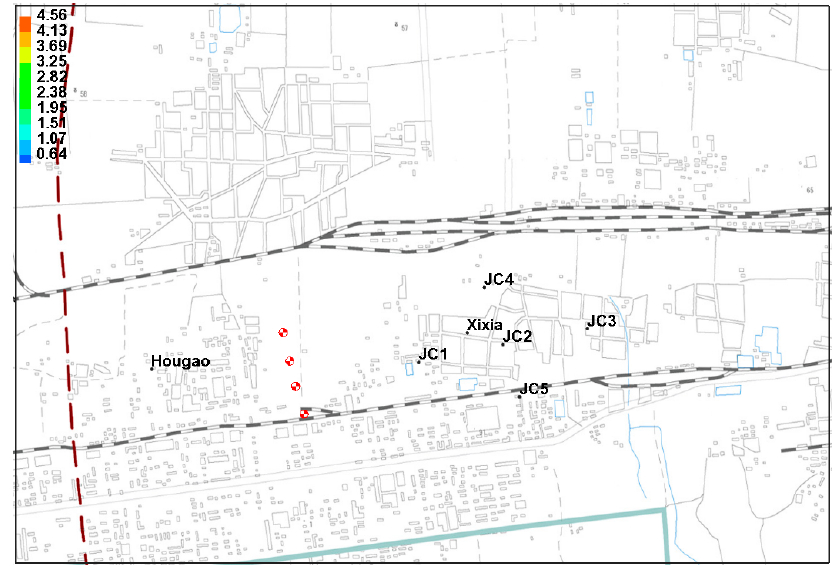
Figure 14. The arrangement of hydraulic interception wells.